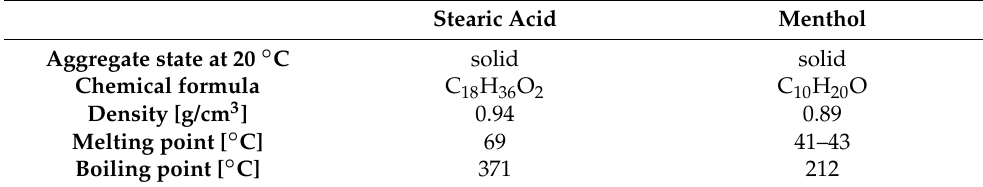
Table 3. Comparison of properties between stearic acid [21] and menthol [22].